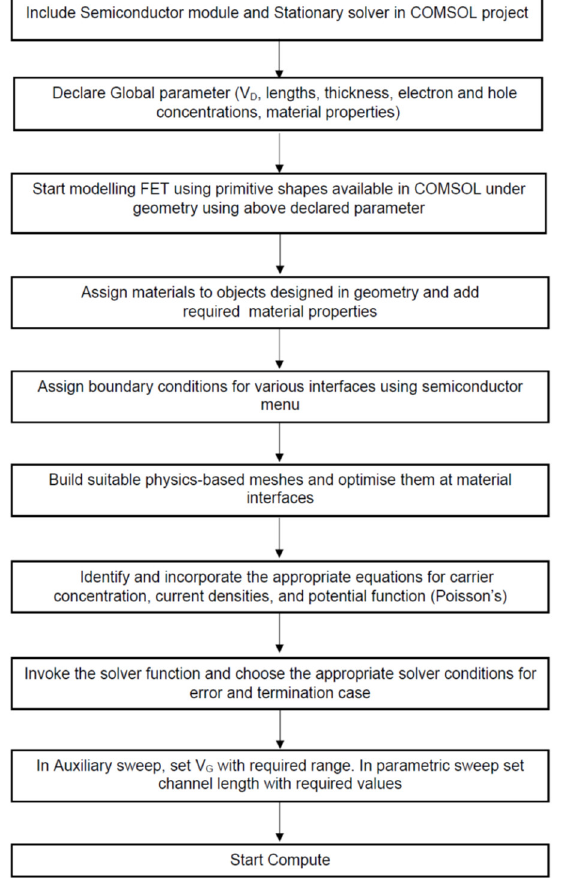
Figure 2. A schematic of the step-wise procedure followed to set up the computational simulation work.